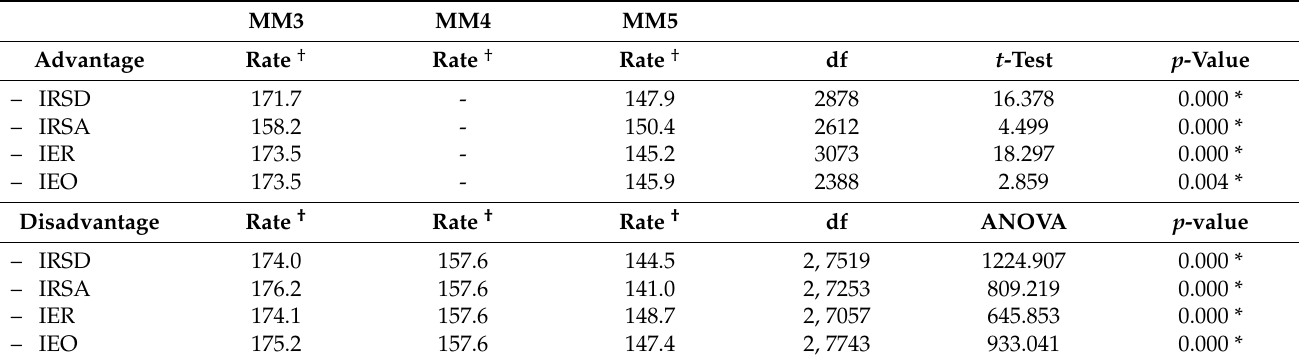
Table 6. Total injury rate differences between levels of rurality according to Advantage and Disadvantage. MM3 MM4